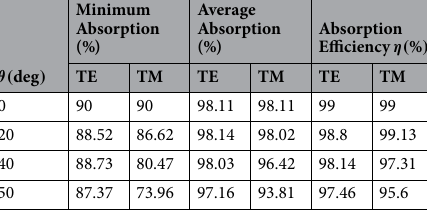
Table 4. Absorption levels and absorption efficiencies for different incident angles of TE and TM